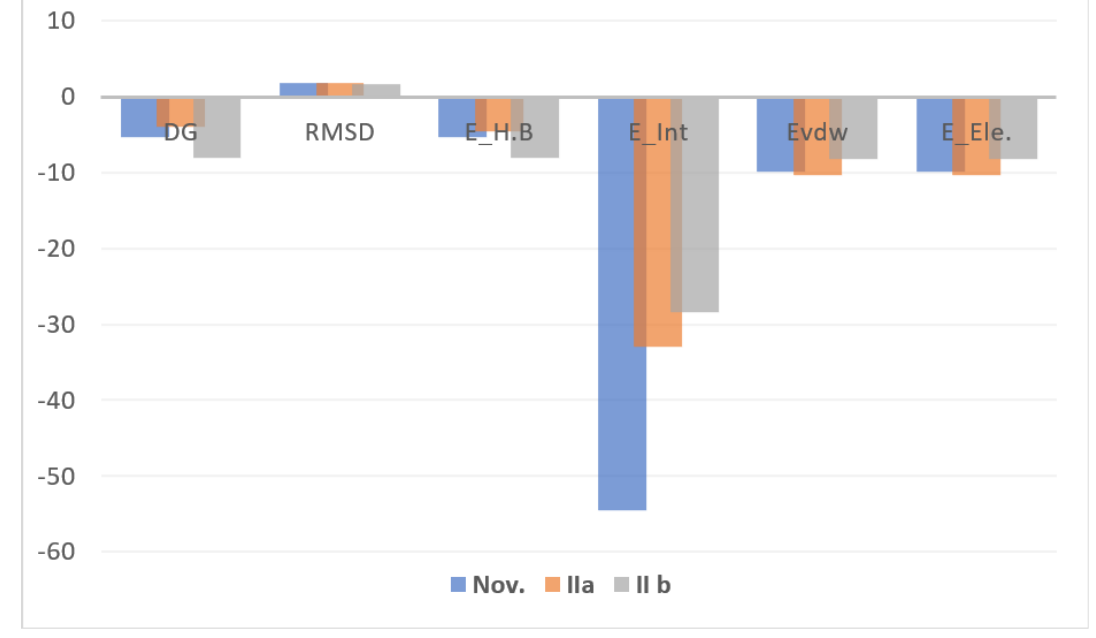
Figure 6. Docking energy scores (kcal/mol) for investigated compounds. Δ G: Free binding energy of the ligand from a given conformer; Int.: Affinity binding energy of hydrogen bond interaction with receptor; H.B.: Hydrogen bonding energy between protein and ligand; Eele: Electrostatic interaction with the receptor; Evdw: Van der Waals